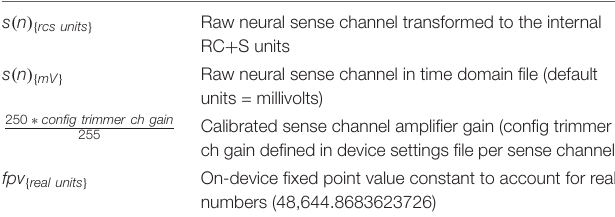
TABLE 5 | Variables and constants to transform RC + S signal back to internal on-device units. s ( n ) { rcs units } Raw neural sense channel transformed to the internal RC + S units s ( n ) { mV }